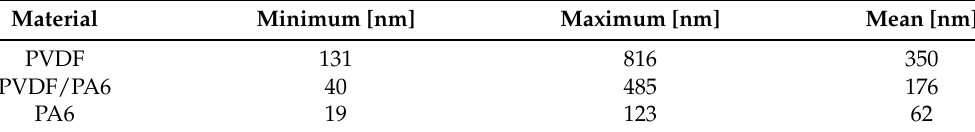
Table 1. Evaluation of measured data sets of nanofiber diameters.